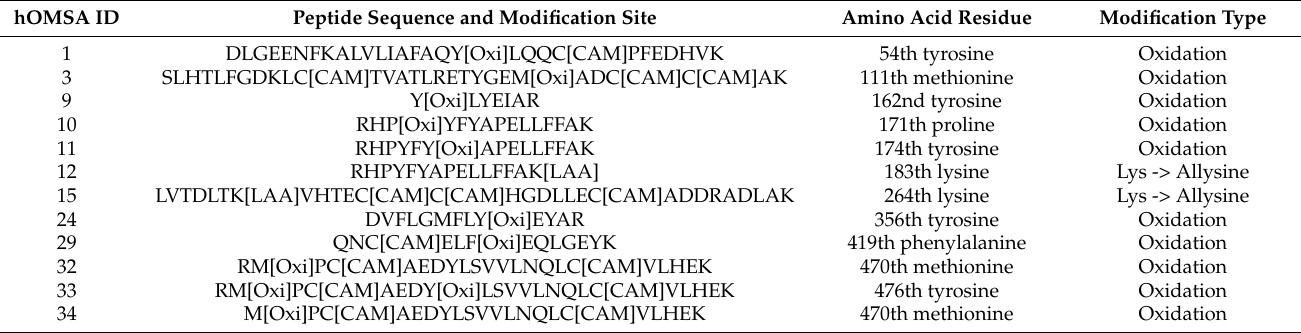
Figure 1. The linear fitting for forecasting the total effective radiation dose using a serum proteome analysis. The linear fitting for forecasting the total effective radiation dose by measuring 15 proteins: IGLC2, IGKV3D − 15, FGA, IGKV2D − 28, IGLV1 − 36, APOB, SERPINF2, PRDM5, APOC4, ZNF536, SERPIND1, HBA1, ORM1, C6, and ORM2. R indicates the correlation coefficient value, and p < 0.05 was considered statistically significant. Table 3. Oxidative modification pattern of peptide sequence constituting human serum